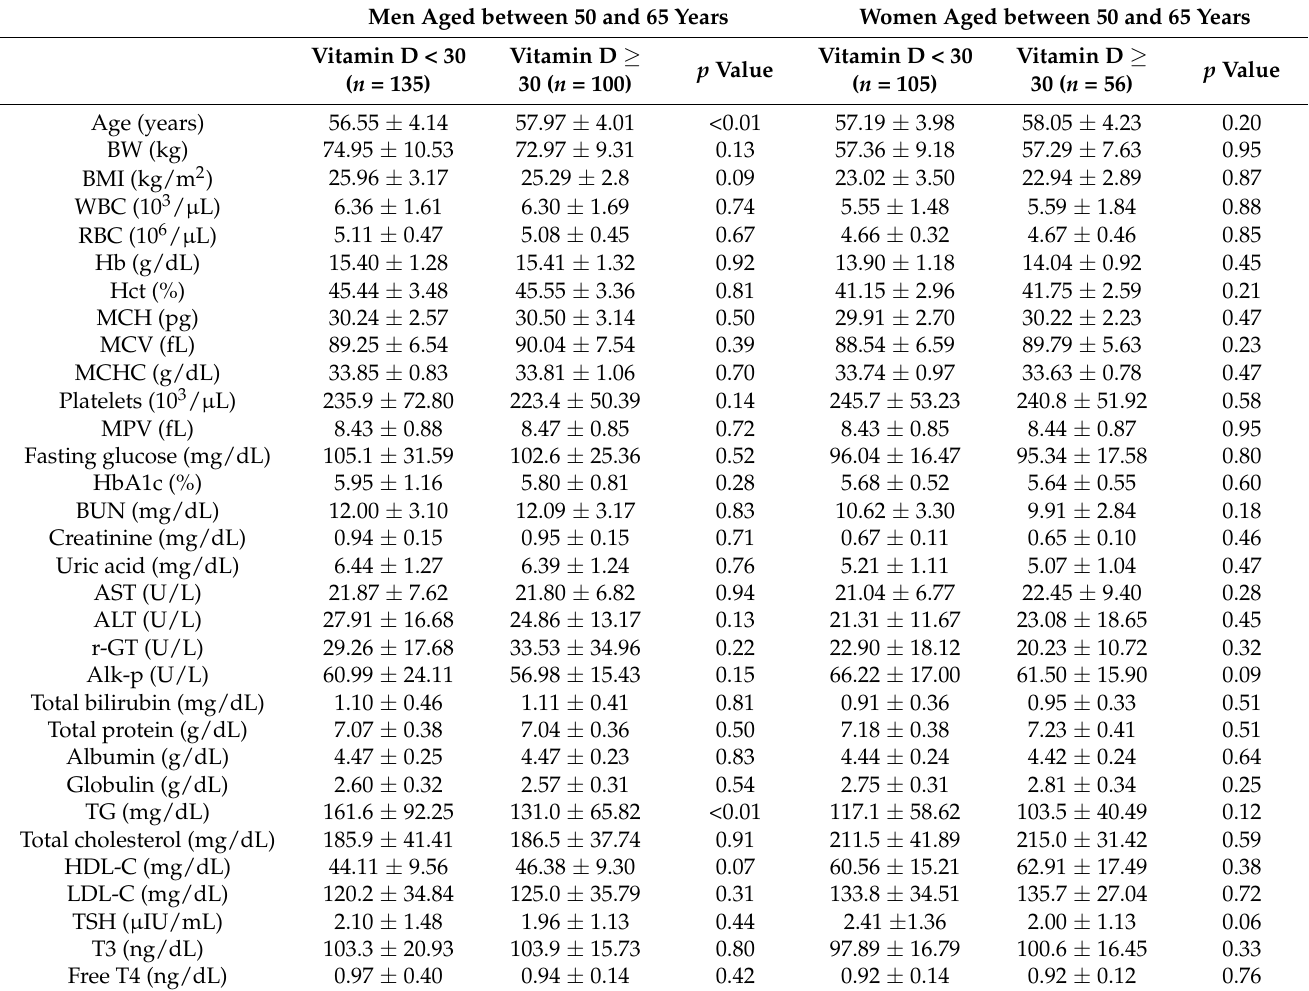
Table 5. Associations between vitamin D status and biomarkers in men and women aged between 50 and 65 years.